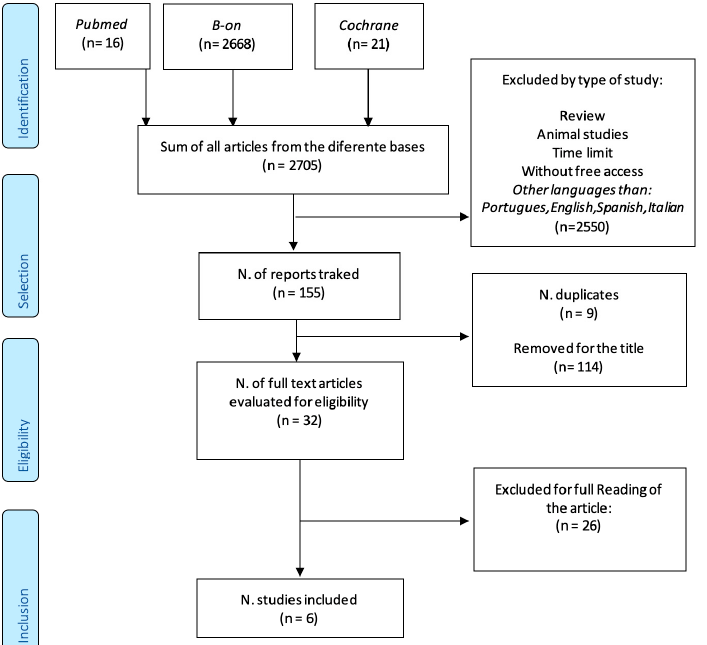
Figure 1. Flow diagram for Preferred Reporting Items for Systematic Reviews and Meta-analysis (PRISMA).